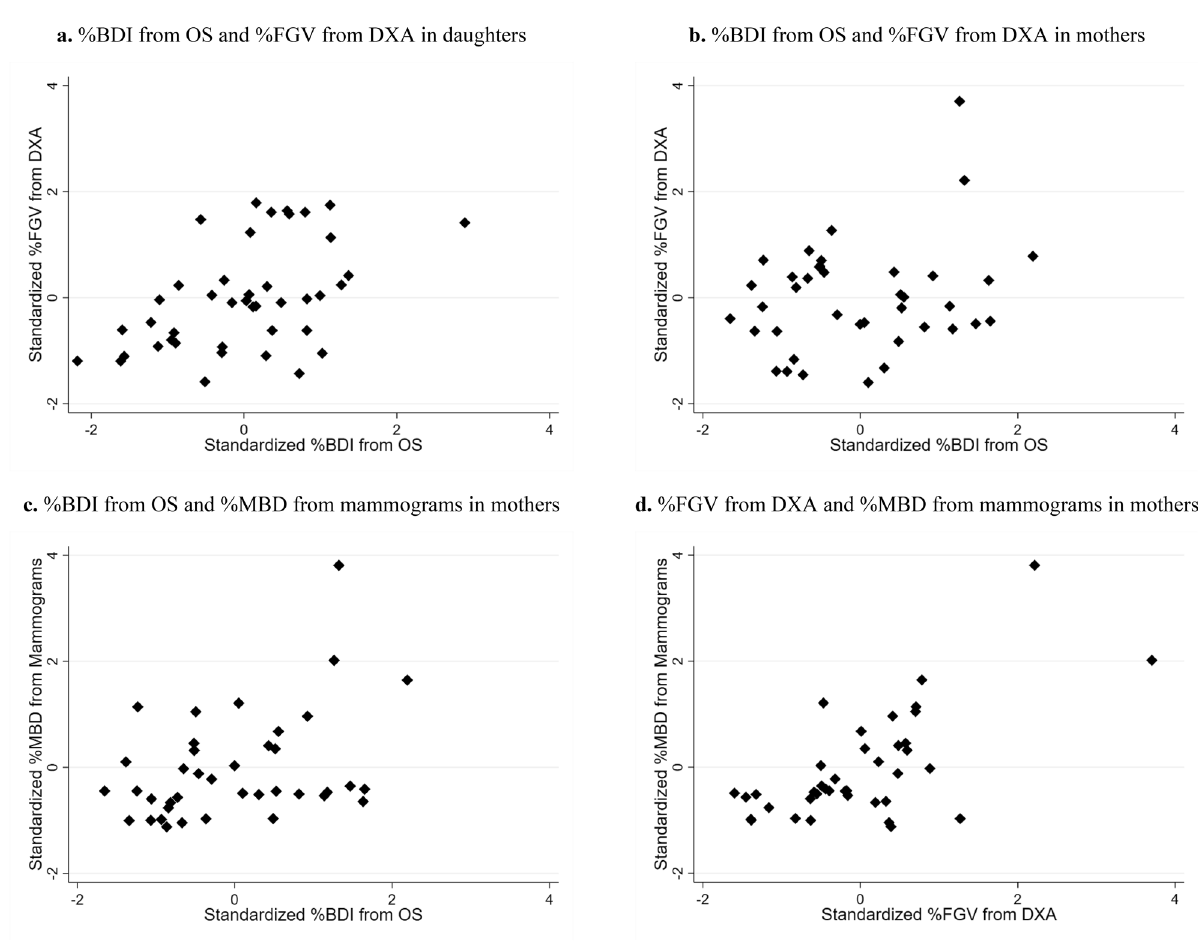
Figure 1. Scatter plots comparing relative measures of breast density from different devices in daughters and mothers from the Growth and Obesity Study in Santiago, Chile. Percent breast density index (%BDI) from optical spectroscopy (OS), percent fibroglandular volume (%FGV) from dual-energy X-ray absorptiometry (DXA) and percent mammographic breast density (%MBD) from mammograms are standardized to a mean of zero and a standard deviation of one. Observed values are presented as diamonds in scatter plots.